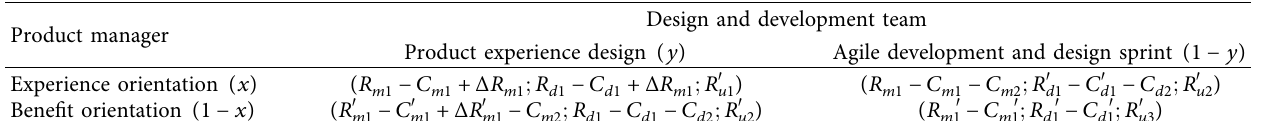
Table 3: Payment matrix under user-selected unauthorized information sharing policy (1 − z